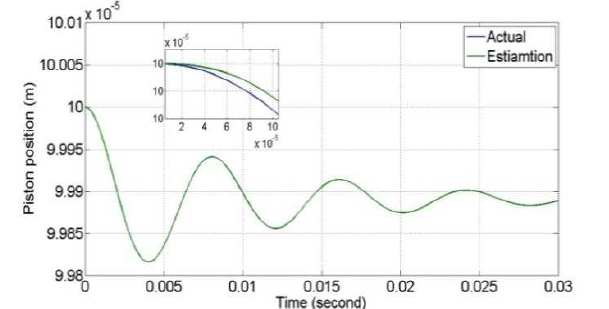
Fig. 6. Open loop piston position estimation under parametric uncertainties. (cid:159) = (cid:160). £